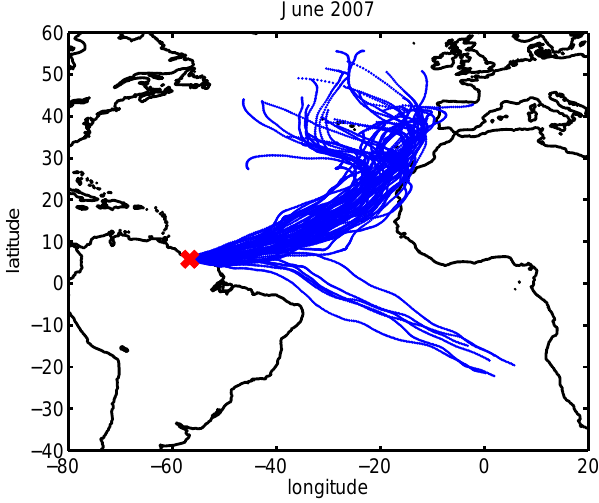
Fig. 1. A batch of 10 days backward trajectories from HYSPLIT-4 in June 2007 (blue) indicating that the air comes from the open ocean most of the time. The red cross marks the measurement location.